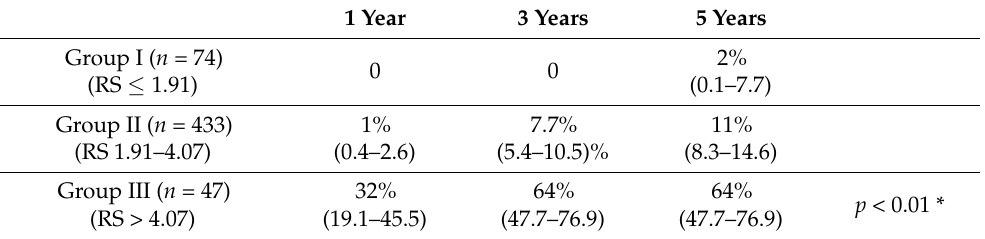
Table 4. Cumulative incidence rates of HCC-specific death based on range of risk score (RS).